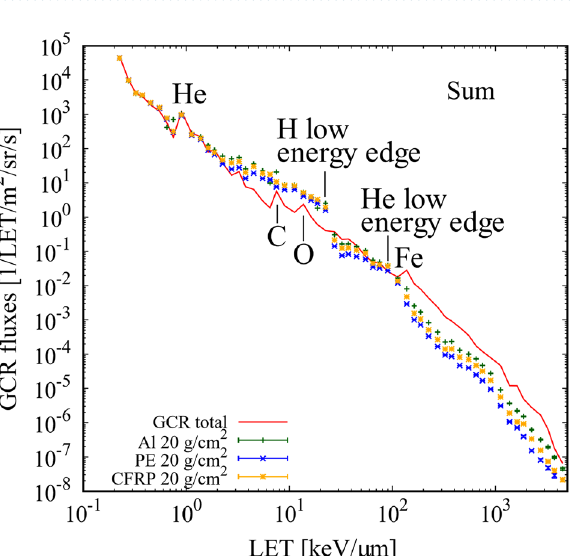
Figure 2. LET spectra of GCR major elements in ICRU four-element tissues in free space and with 20 g/ cm 2 shielding. ( a ) H, ( b ) He, ( c ) C, ( d ) Ne, ( e ) Si, and ( f ) Fe. Red line denotes GCR primary element in free space. Green, blue, and yellow denote GCR primary element with 20 g/cm 2 shielding with Al, PE, and CFRP, respectively.